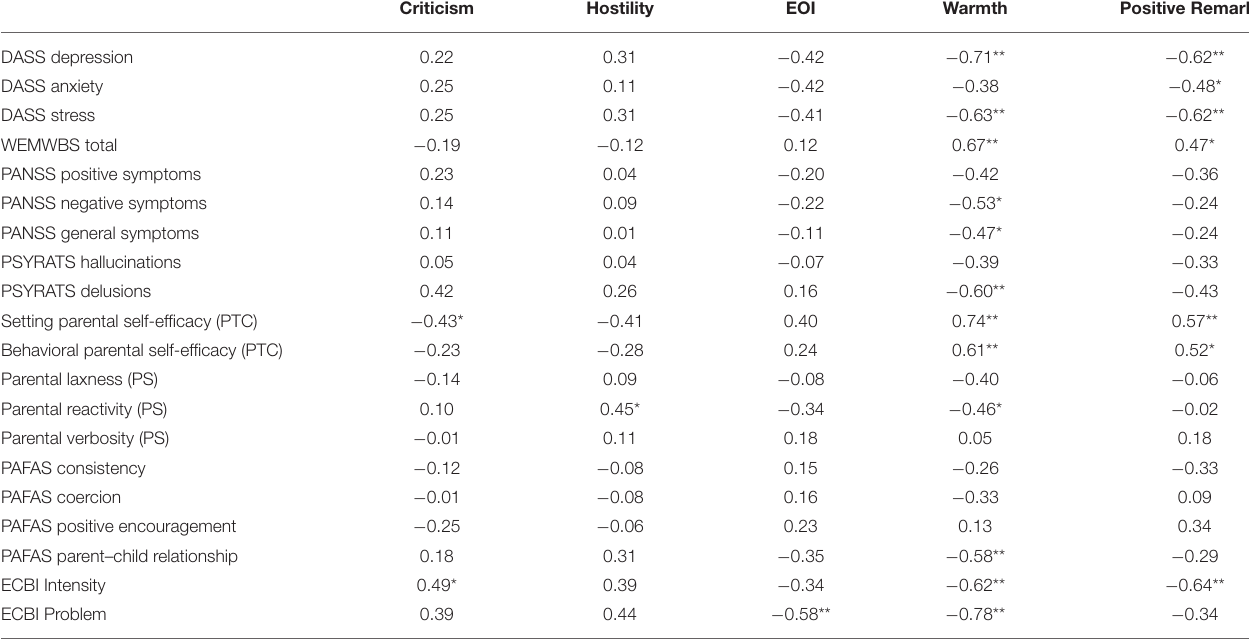
TABLE 4 | Correlations between EE, mental health, parenting and child behavior in parents with schizophrenia.